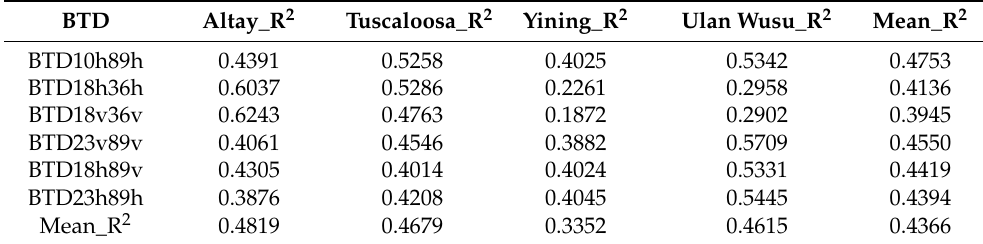
Figure 6. Daily snow depth and brightness temperature difference (BTD) at ( a ) Altay, ( d ) Tuscaloosa, ( c ) Yining and ( d ) Ulan Wusu. SD is abbreviation of snow depth. BTD is abbreviation of brightness temperature difference. K is abbreviation of Kelvins. Table 2. Coefficient of determination between snow depth and BTD at Altay, Tuscaloosa, Yining and Ulan